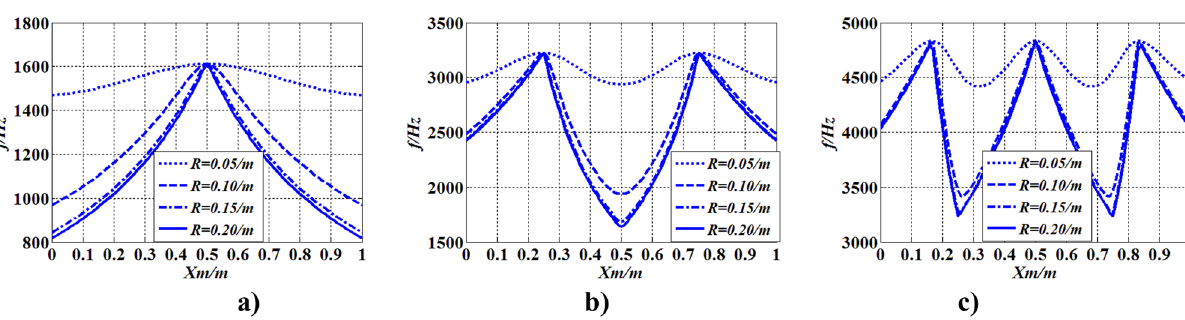
Figure 14. Changes of frequencies with R ( J m ) and x m